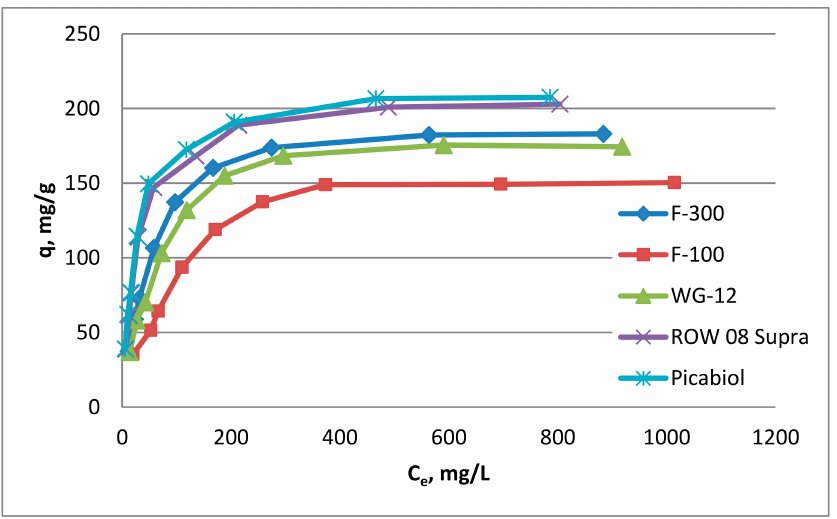
Figure 3. Isotherms of chloramphenicol adsorption on commercial activated